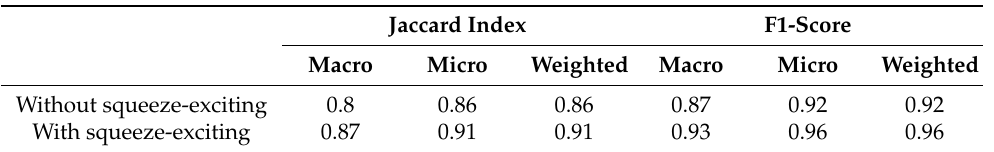
Table 2. Comparison of the Jaccard index and F1-score achieved without and with squeeze-exciting blocks for the test